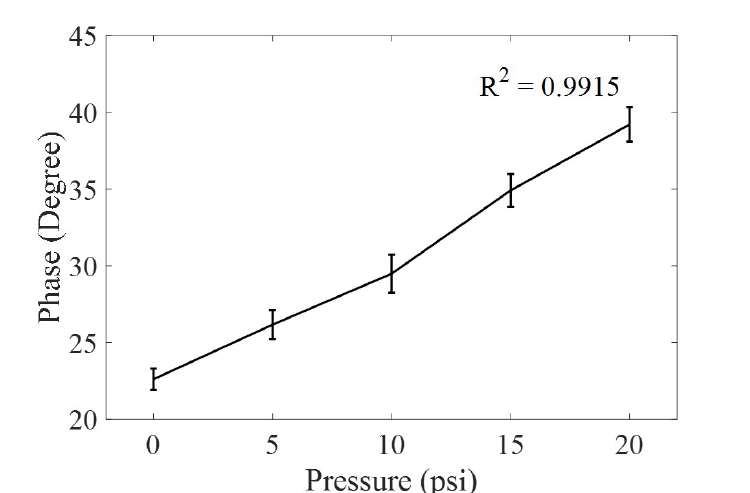
Figure 13. Phase change is wirelessly measured using harmonic RF interrogator due to applied pressure ranging from 0 to 20 psi. The linearity of change in phase due to pressure is represented using coefficient of determination ( R 2 =